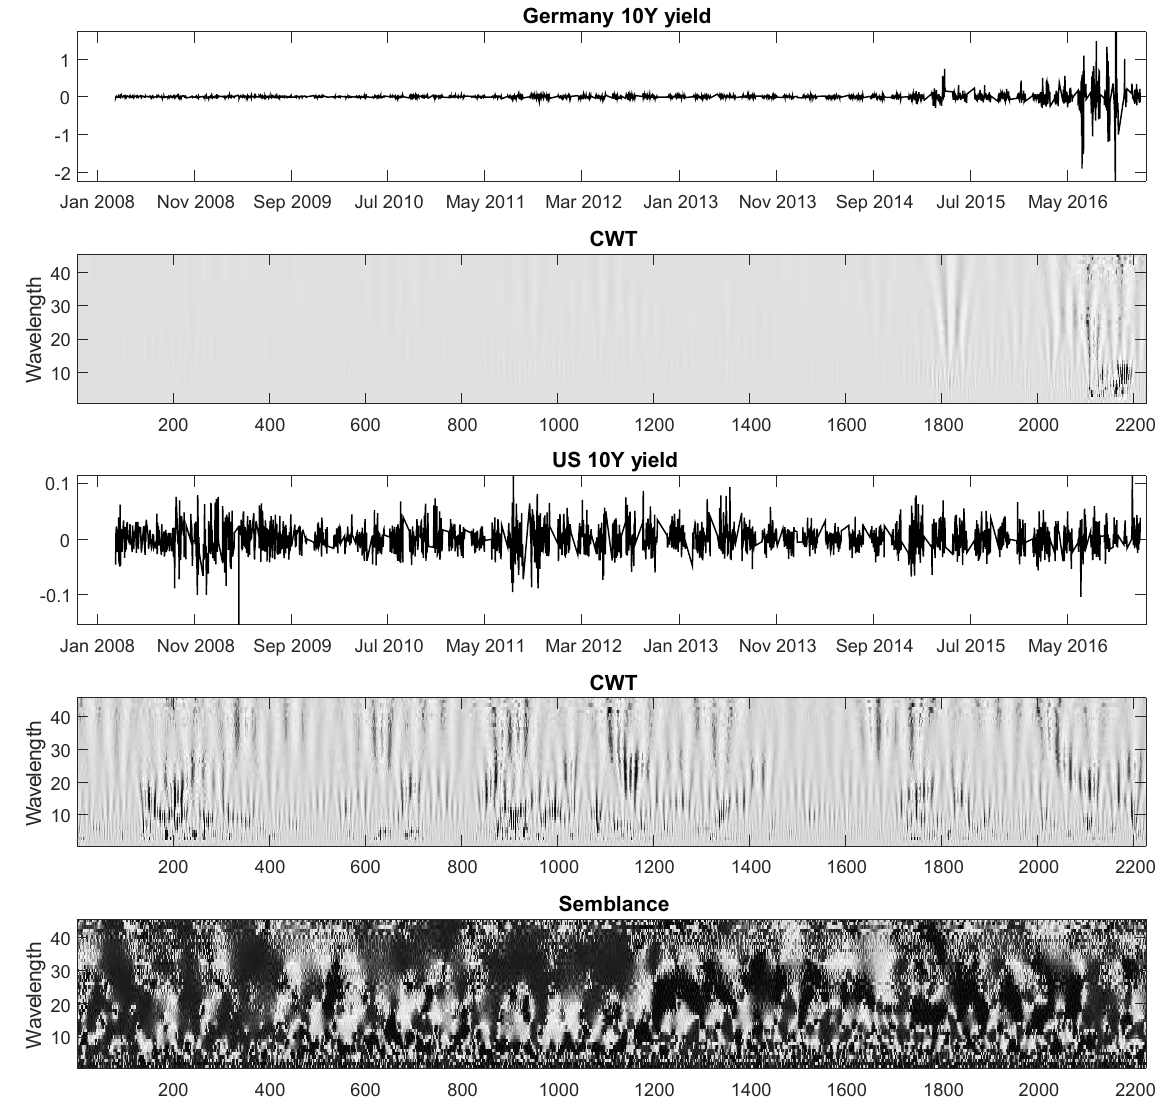
Figure 3. German 10 year bond and US 10 year treasury yield